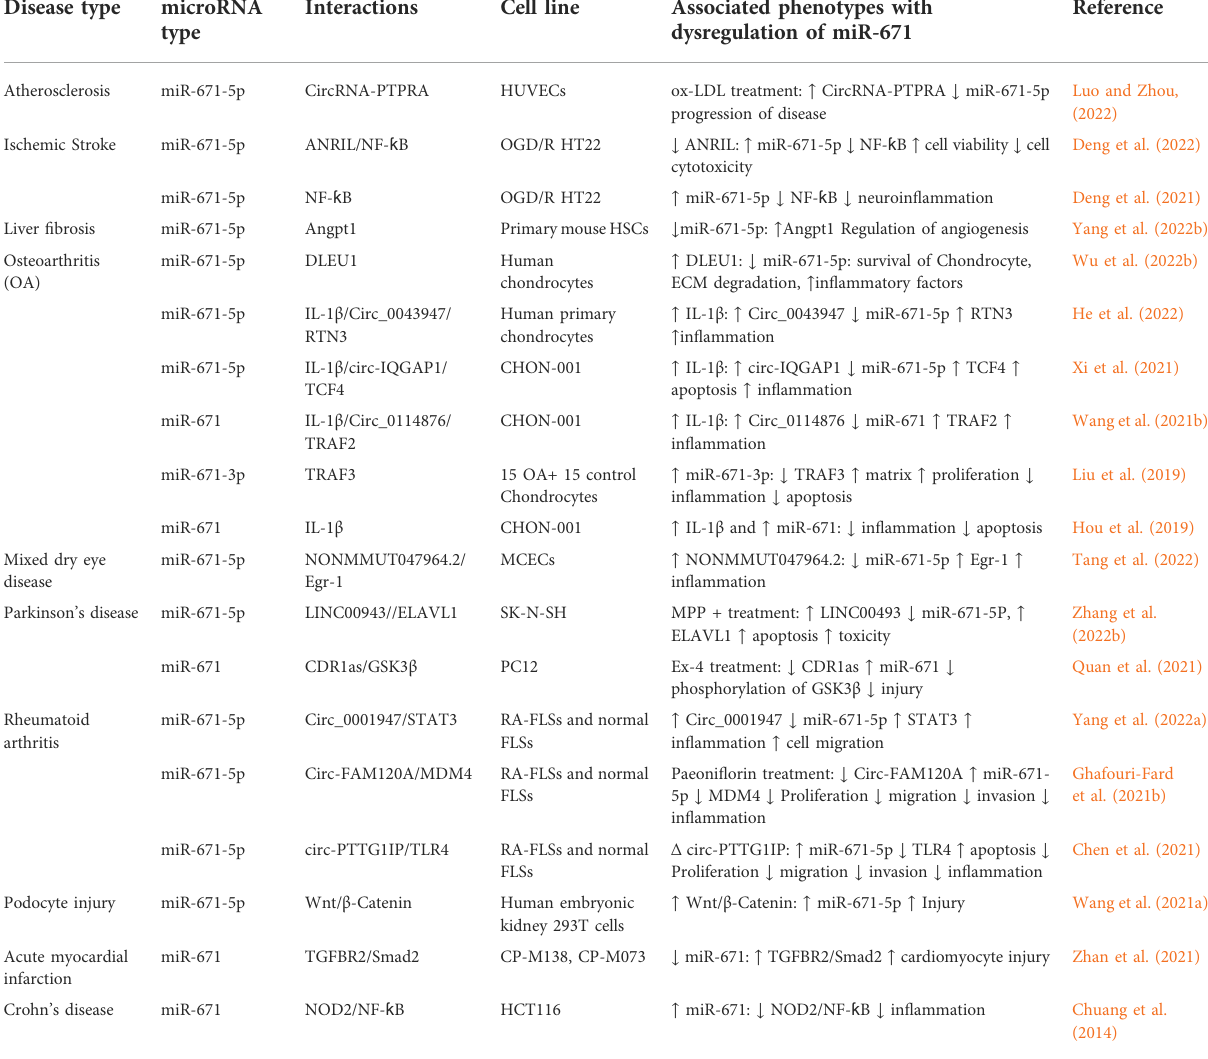
TABLE 4 Cell line studies showing the role of miR-671 in non-malignant conditions.